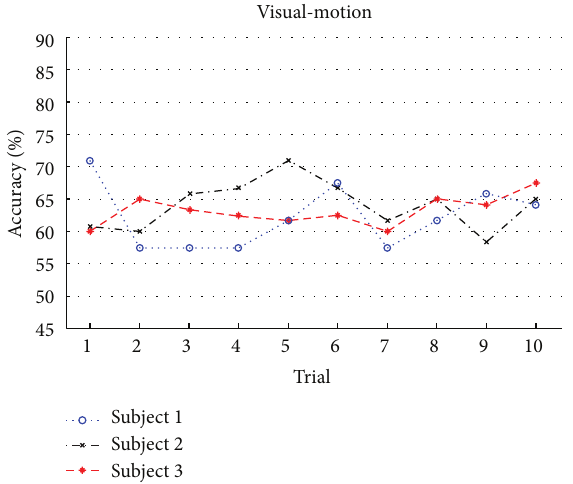
Figure 7: Classification accuracy of the visual and motion stimuli.